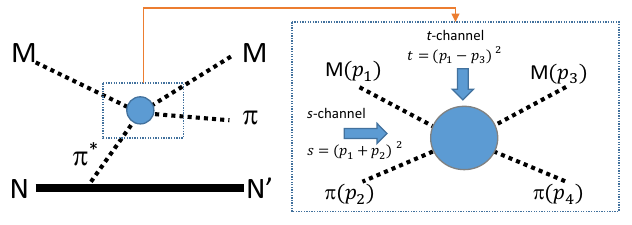
Figure 2. Schematic representation of the extraction of meson-meson scattering data, where M = π, K , by considering it a sub-process that contributes to a larger MN → M π N collision. For the extraction, the experiment looks for the kinematic region where the exchanged virtual pion is close to being real. In the right panel we define the Mandelstamm s and t variables, which correspond to the total energy squared in the center of mass of their respective scattering channels.